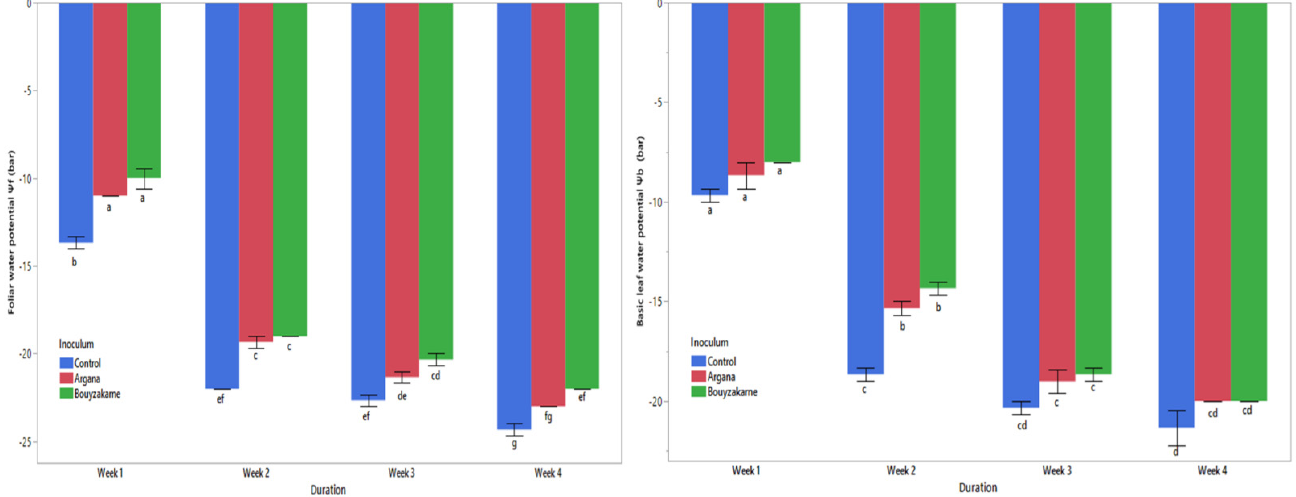
Figure 1. Foliar water potential ( Ψ f) and basic leaf water potential ( Ψ b) of mycorrhizal and non-mycorrhizal argan plants subjected to the stress of soil water deficit for one month (each error bar is constructed using 1 standard error from the mean). Values with different letters are significantly different (Tukey’s test p ≤ 0.05).